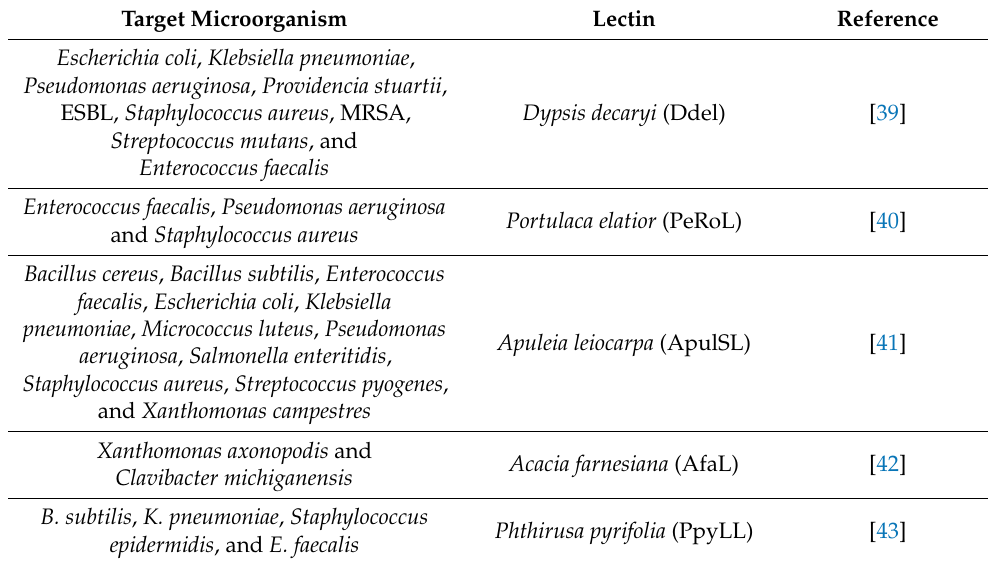
Table 1. Lectins with antibacterial